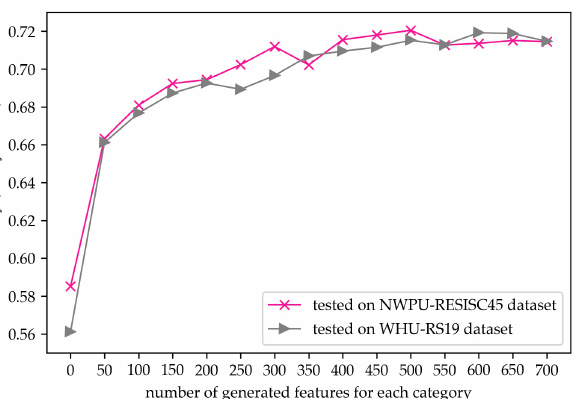
Figure 10. Accuracies with the increasing of generated features tested in the case of 5-way